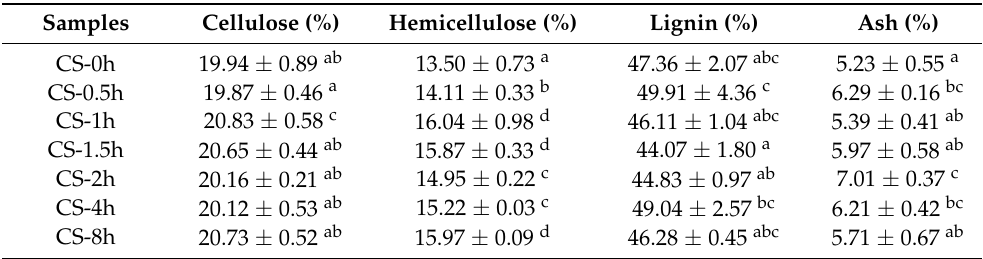
Table 1. The cellulose, hemicellulose, lignin, and ash contents of the corn straw samples with different ball grinding times. CS—corn straw.